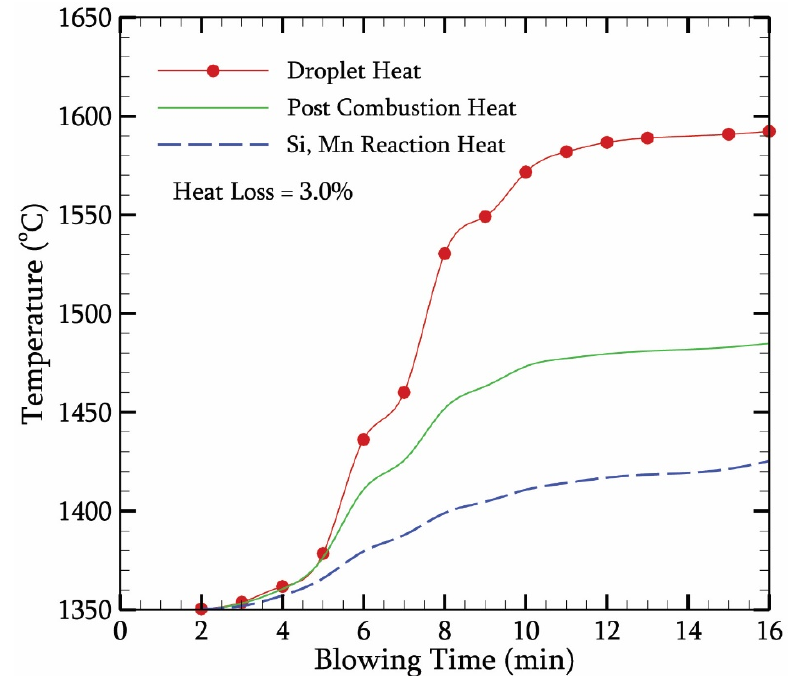
Figure 8. Slag temperature evolution profiles based on individual heat components for a heat loss of 3%.